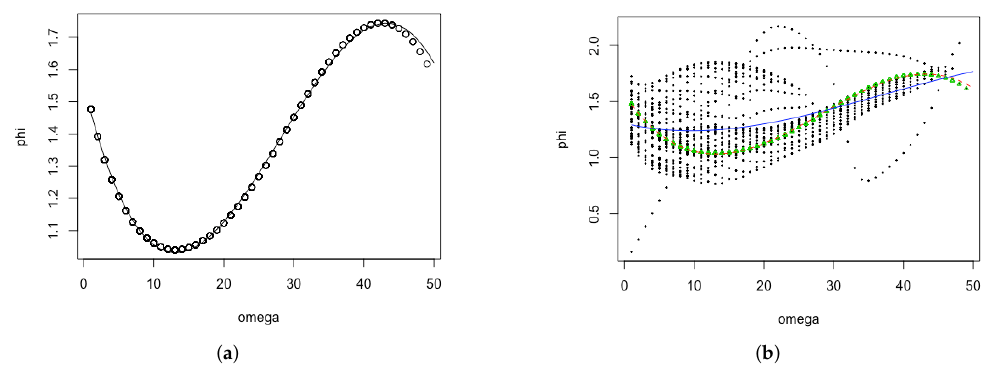
Figure 3. Plot of φ jk s against their corresponding ω jk s. ( a ) Plot of φ jk s against their corresponding ω jk s, with γ null under sequential order 1, . . . ,50, and the solid line in the true model. ( b ) Plot of φ jk against ω jk under new order 50,2, . . . ,49,1 in dots. The solid line is the fitted line with ˆ γ 1/50 , while the dotted line stands for the γ null model.